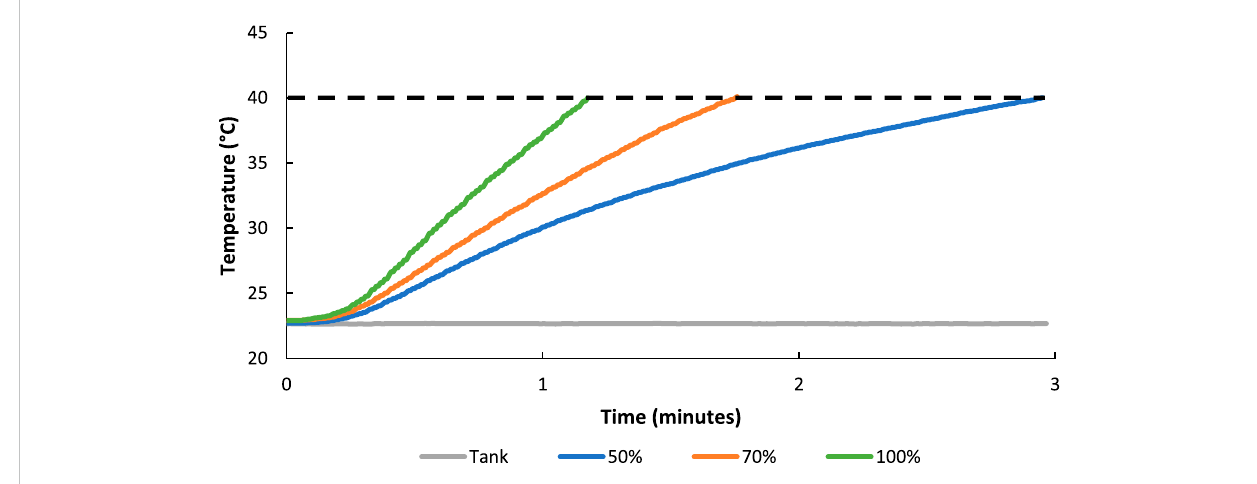
FIGURE 9 The rate of FUS controlled heating of hydrogels to 40 ° C was altered by setting the duty cycle of the driving signal to 50, 70, and 100% with the amplitude set constant at ±5.8 MPa.